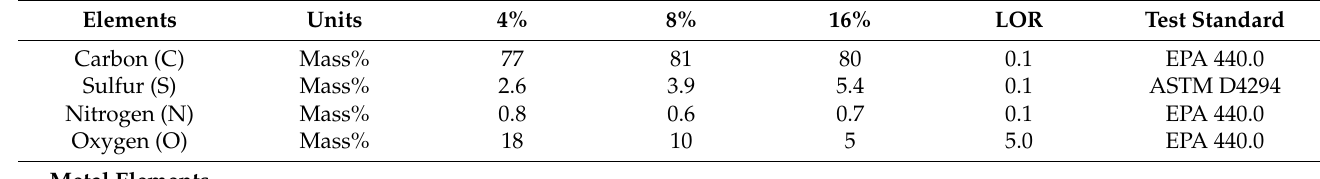
Table 4. Analysis of the compositions of solid particle emissions.